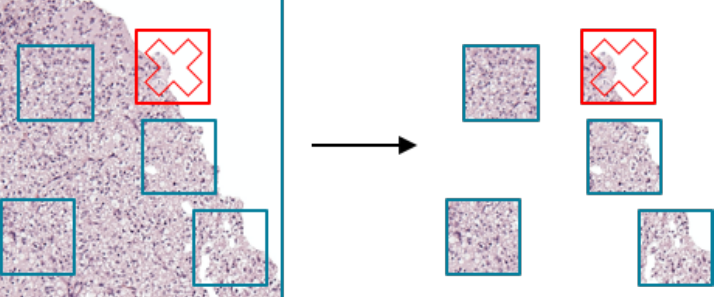
Figure 2. Random patch selection from region of interest images. The patch that wsa filled with more than 50% of white background was discarded (red